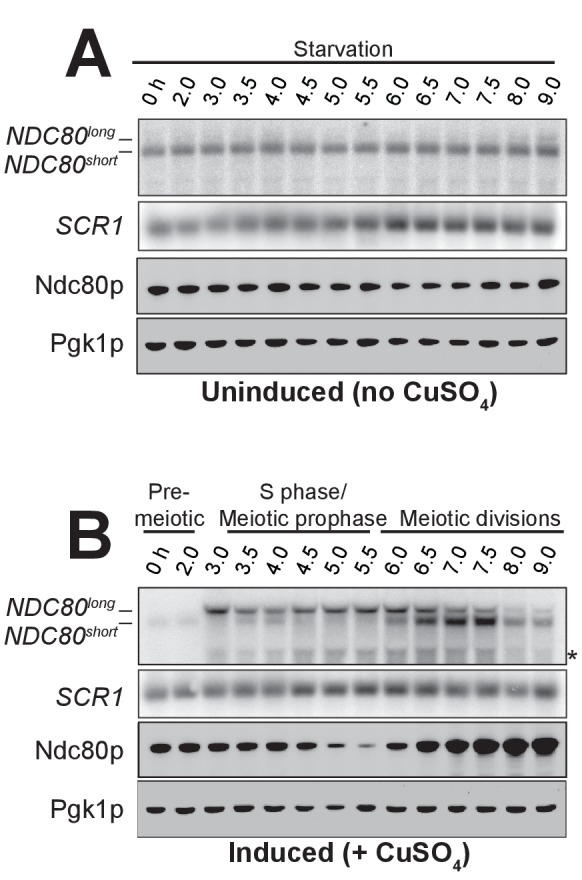
During starvation, NDC80short and Ndc80 protein levels remain high, while NDC80long is not expressed.The abundance of NDC80 mRNA isoforms and Ndc80 protein level in starvation versus in meiosis. NDC80long and NDC80short were detected by northern blot, and Ndc80, by anti-V5 immunoblot. SCR1, loading control for northern blot. Pgk1, loading control for immunoblot. Cells harboring the pCUP-IME1 pCUP-IME4 system (UB1337) were transferred into SPO at 0 hr. After 2 hr, the culture was split into two: In one half, IME1 and IME4 expression was never induced, and thus cells stayed in starvation (A). In the other half, IME1 and IME4 expression was induced by addition of CuSO4 (B). * indicates a smaller RNA product, which likely represents a truncated form of NDC80long. Note: the samples in the induced conditions are the same as in Figure 2B, but the northern blot in this figure was a rerun of Figure 2B, and the immunoblot has a different loading control displayed.